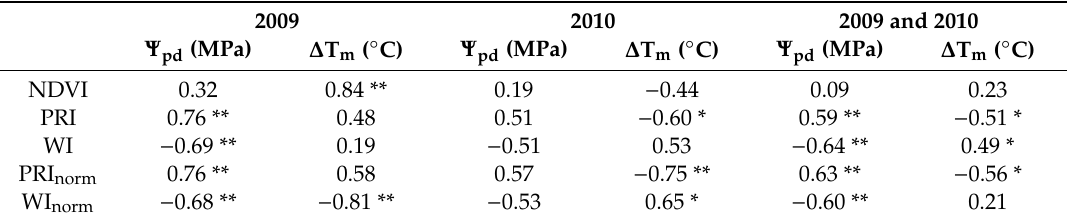
Table 2. Correlation coefficients between predawn water potential ( Ψ pd ), canopy-to-air temperature difference at midday ( Δ T m ), and reflectance indices. Data are averaged values per plot ( n = 14 in 2009, except for Δ T m where n = 8; and n = 12 in 2010). Significant correlations at the 0.05 (*) and 0.01 (**) level are indicated. NDVI—normalized difference vegetation index.